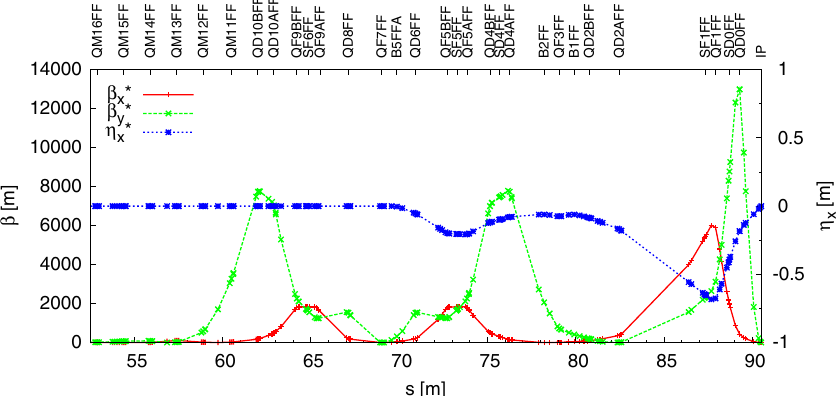
FIG. 2 (color online). The β x;y functions and the η x function for the ATF2 nominal lattice throughout the ATF2 final focus line. by the Shintake monitor ( σ (cid:1) y; ) is obtained by a code that Shi